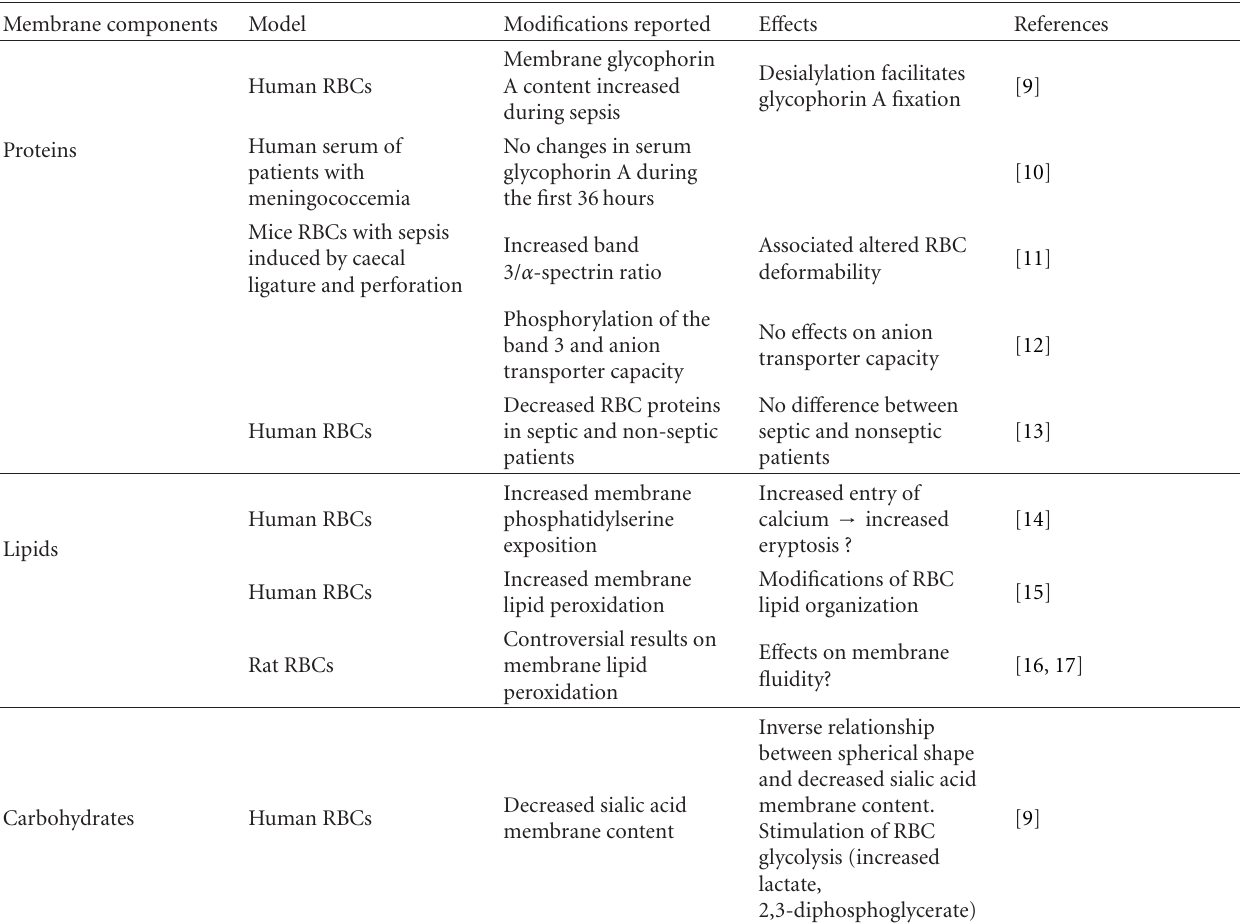
Table 1: Main modifications of the RBC membrane observed during